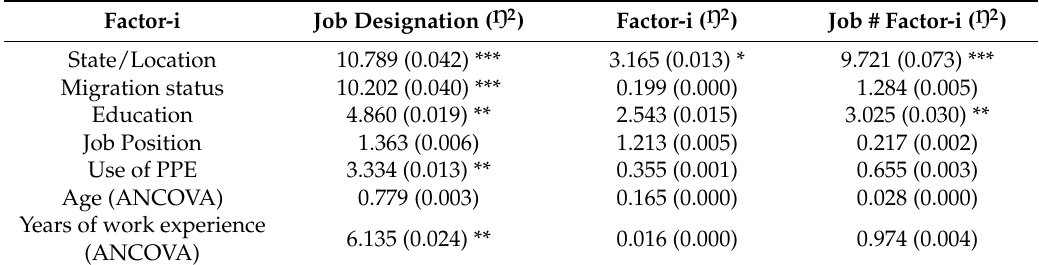
Table 4. F -values of the Two-Way ANOVA for the Attitude score.